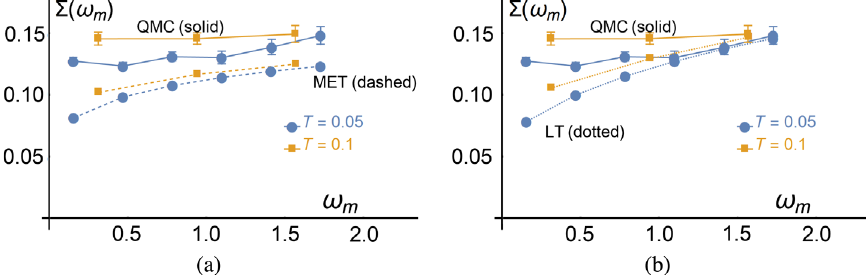
FIG. 6. Fermionic self-energies in the spin-fermion model. (a) Comparison of the MET and QMC self-energy. (b) Comparison of the LT and QMC